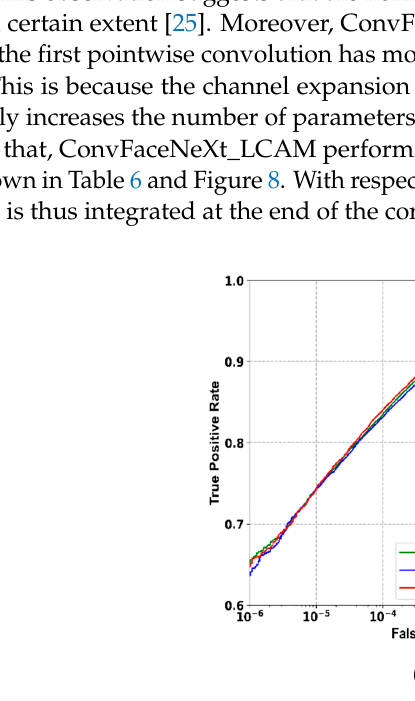
Figure 8. ROC curves on di ff erent integration strategies. ( a ) IJB-B dataset; ( b ) IJB-C dataset.